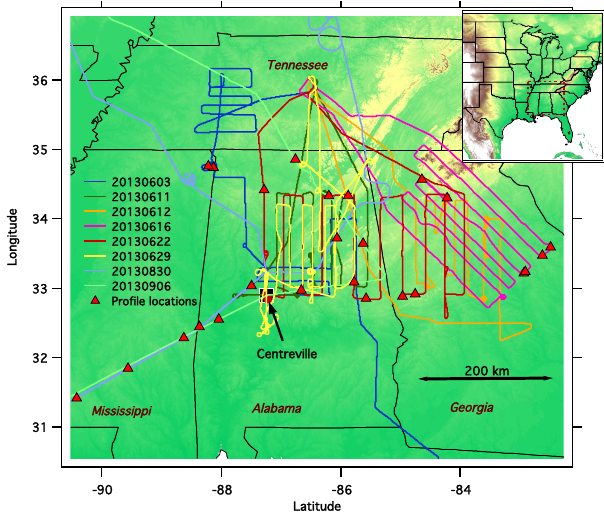
Figure 2. Map of the southeastern US showing state borders and tracks of the flights during SENEX and SEAC4RS. Triangles show the locations of the 37 vertical profiles that are used in this analysis; 25 of these had valid f (RH) measurements. The location of the ground site in Centreville, Alabama, is indicated. The inset shows the eastern portion of the US; the dashed box indicates the sample